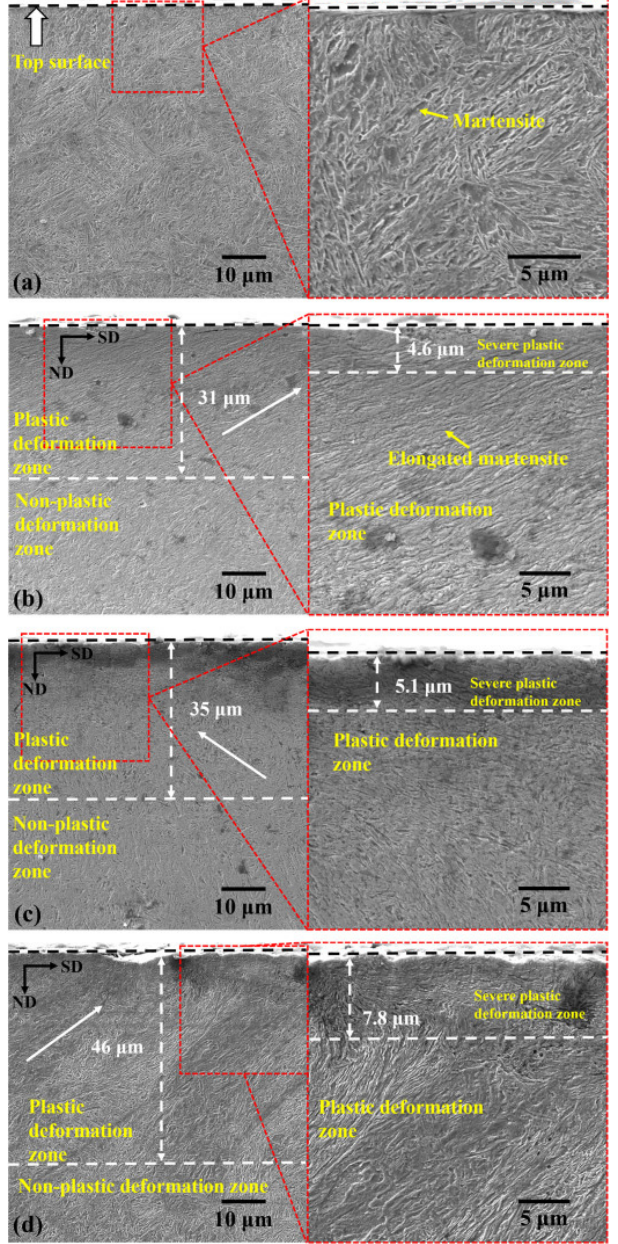
Figure 19. SEM of ( a ) 300 M steel, ( b ) UNSM’ed substrate, ( c ) CC-UNSM’ed substrate, and ( d )